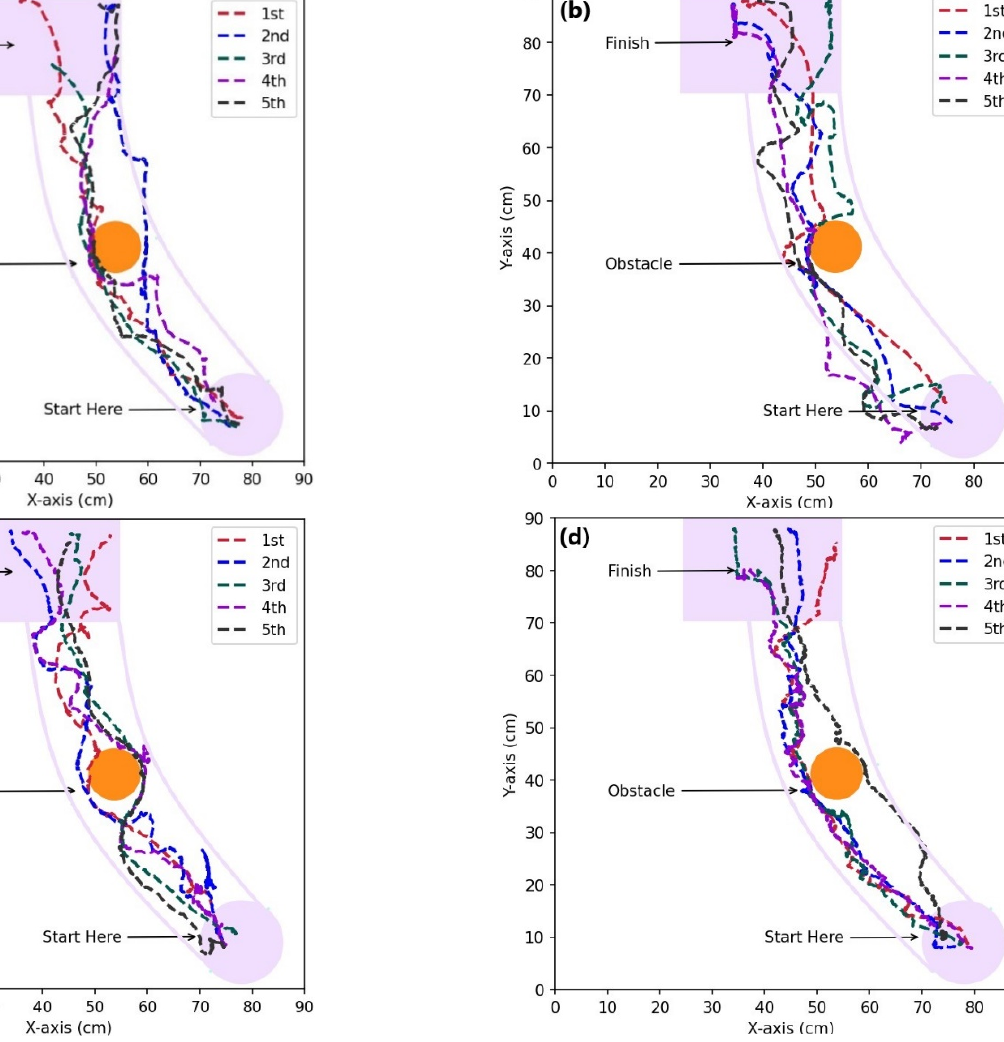
Figure 15. Teleoperated operation of path following with obstacle: ( a ) first cockroach, ( b ) second cockroach, ( c ) third cockroach, ( d ) fourth